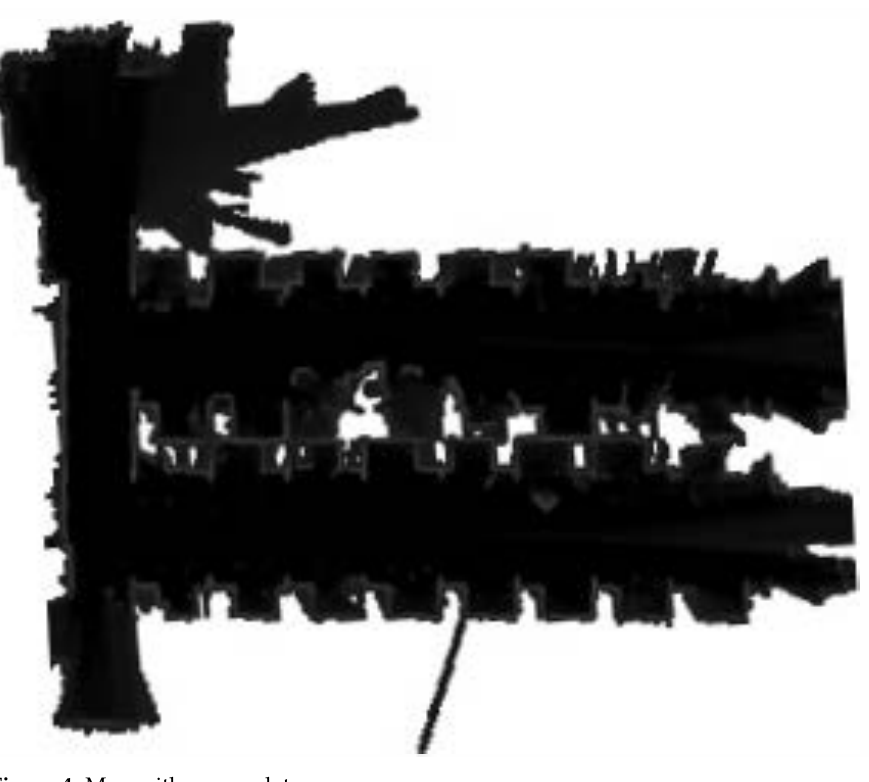
Figure 4. Map with source data.